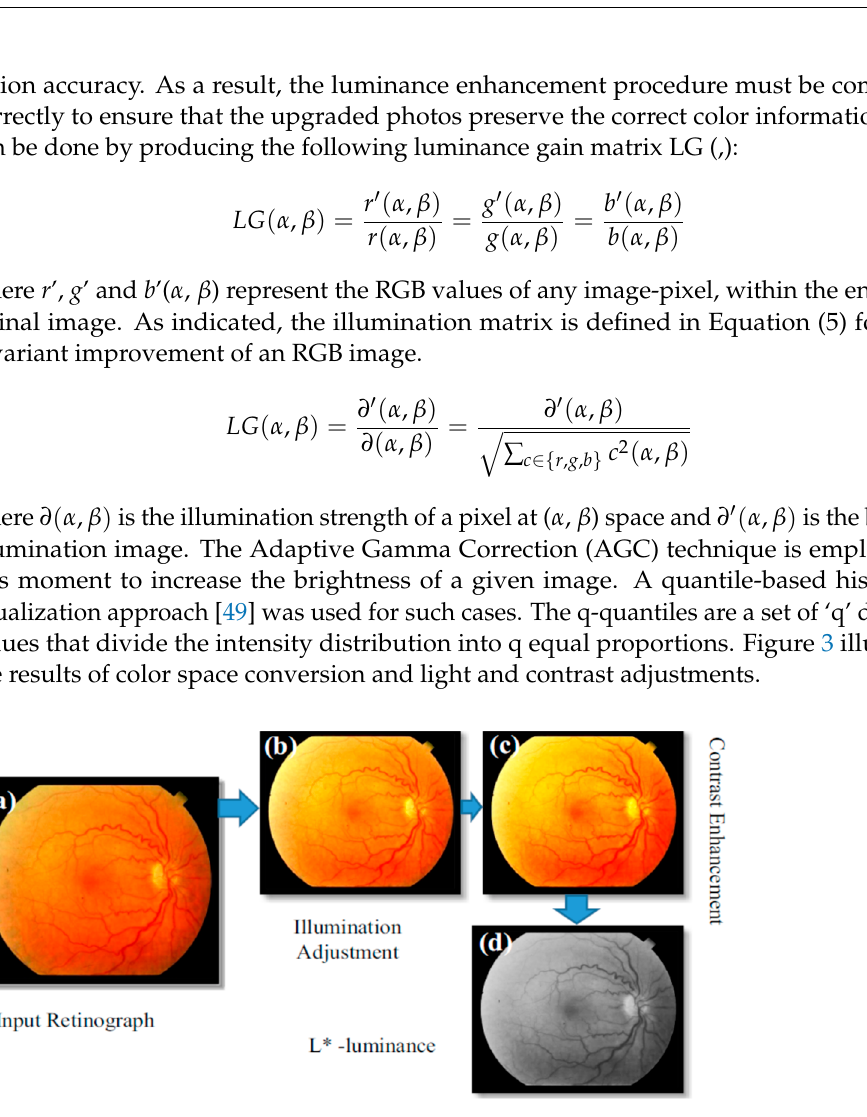
Figure 3. A visual example of the color space conversion and Light Adjustment and Contrast En- hancement, where L* is the luminance adjusted color plane. Enhancement, where L* is the luminance adjusted color plane.